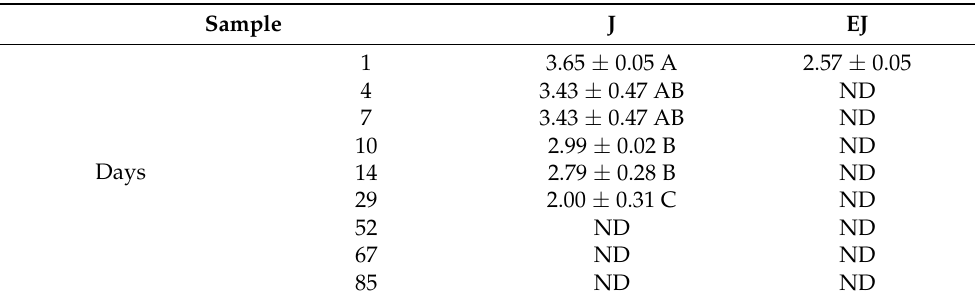
Table 8. Growth of C. jejuni (log cfu/g) in chicken broth during storage for 85 days: with inoculum (J); with 8% of spray-dried extract and inoculum (EJ).